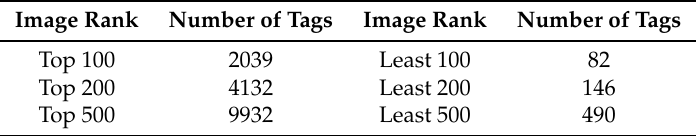
Table 5. The gap in the number of tags between popular and unpopular